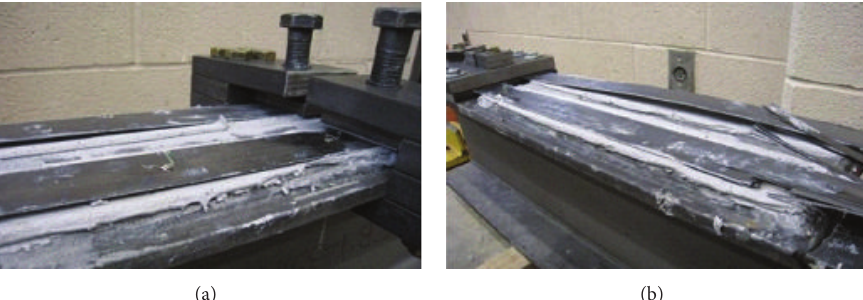
Figure 14: Performance of end anchorage after failure for steel beam strengthened with prestressed strips to the cover plate (a) removable end anchor and (b) fixed end anchor [68].